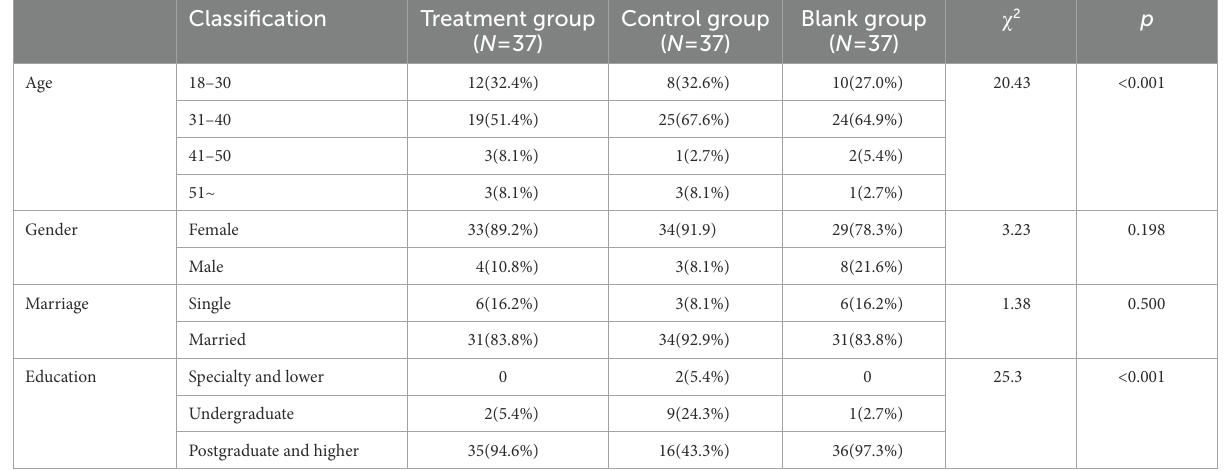
TABLE 1 Demographic data comparison for three